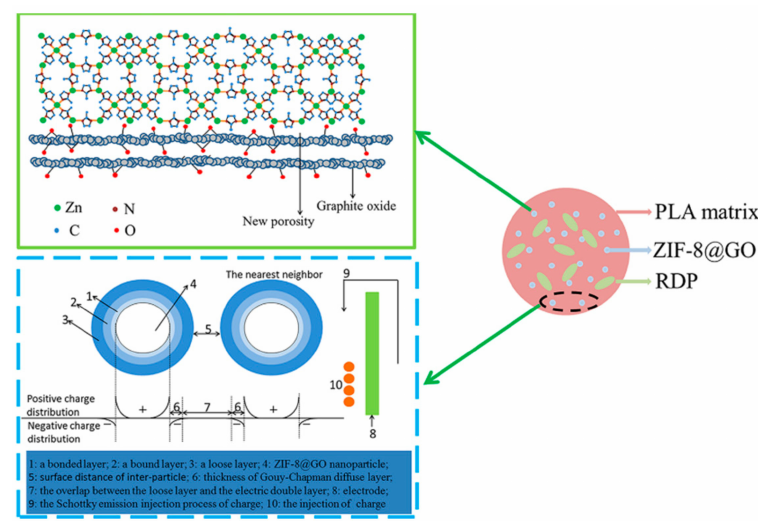
Figure 9. Mechanism of the dielectric permittivity reduction for the films. ( a ) Nanoparticle effect; ( b ) Interface effect